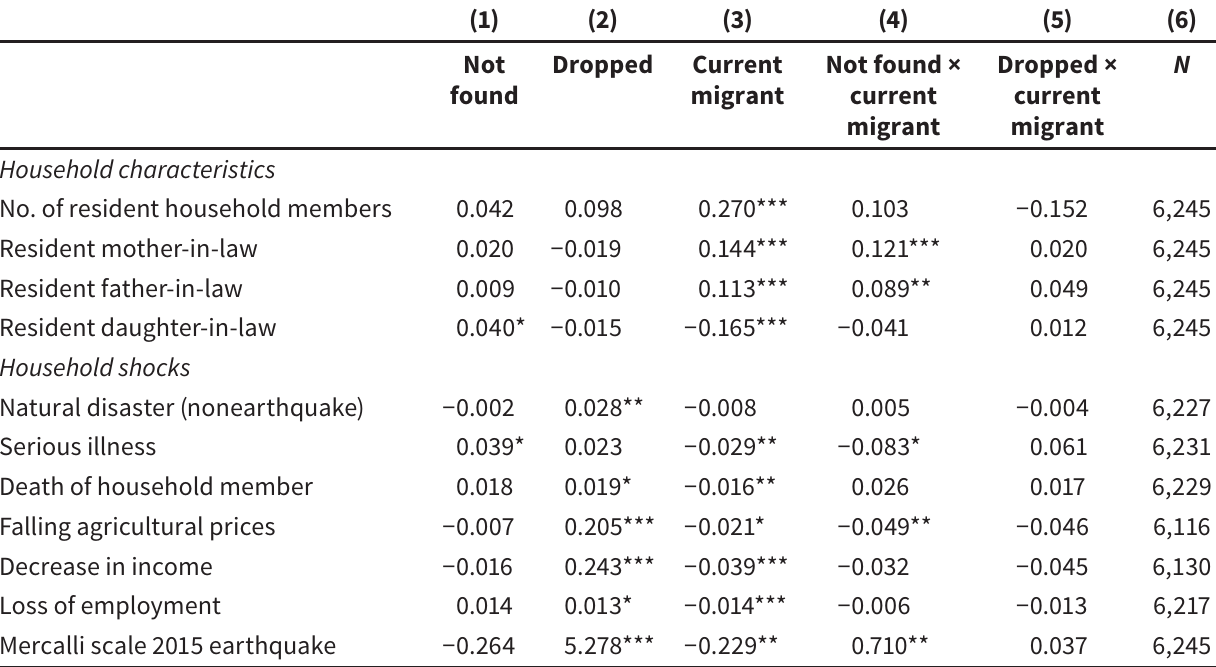
Selection into attrition by migration status over time